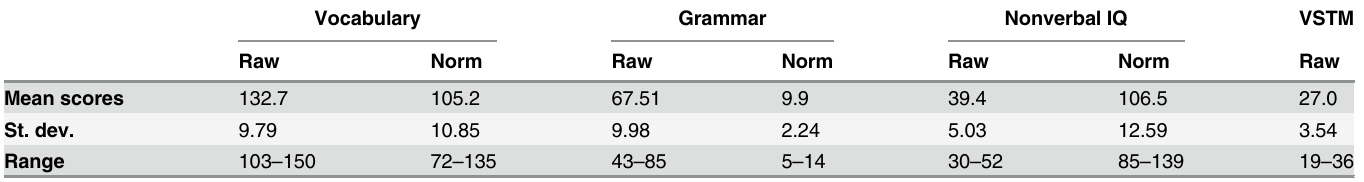
Table 6. Children ’ s mean raw and norm scores, standard deviations and ranges on the receptive vocabulary, grammar, nonverbal intelligence and verbal short-term memory